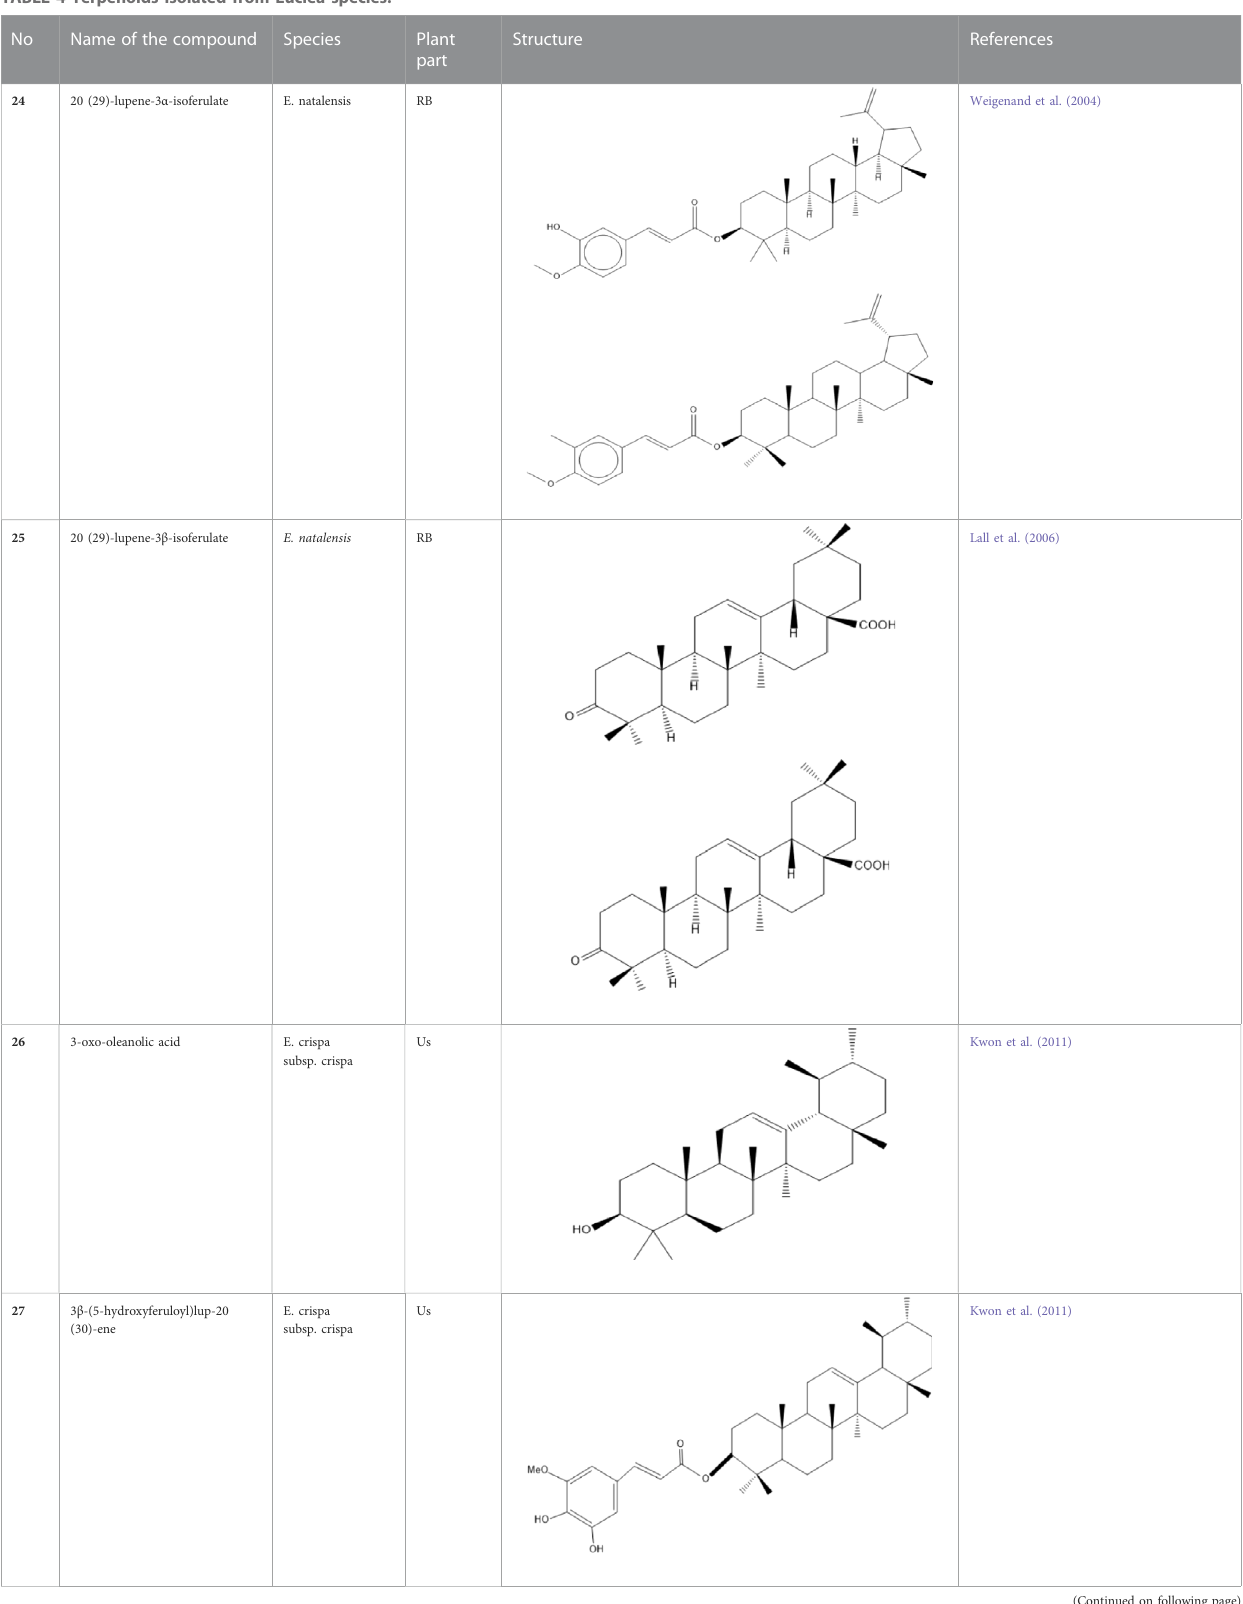
TABLE 4 Terpenoids isolated from Euclea